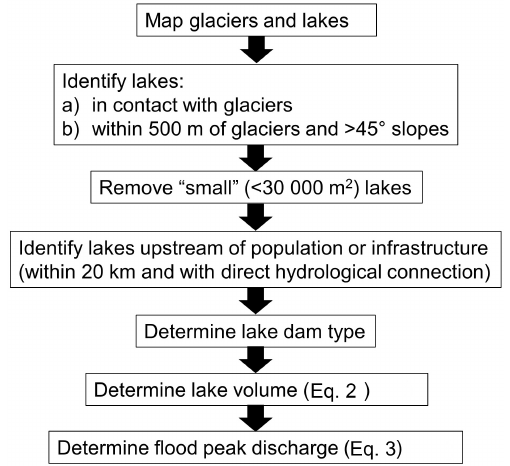
Figure 2. Flow diagram summarising the process of identification of dangerous glacial